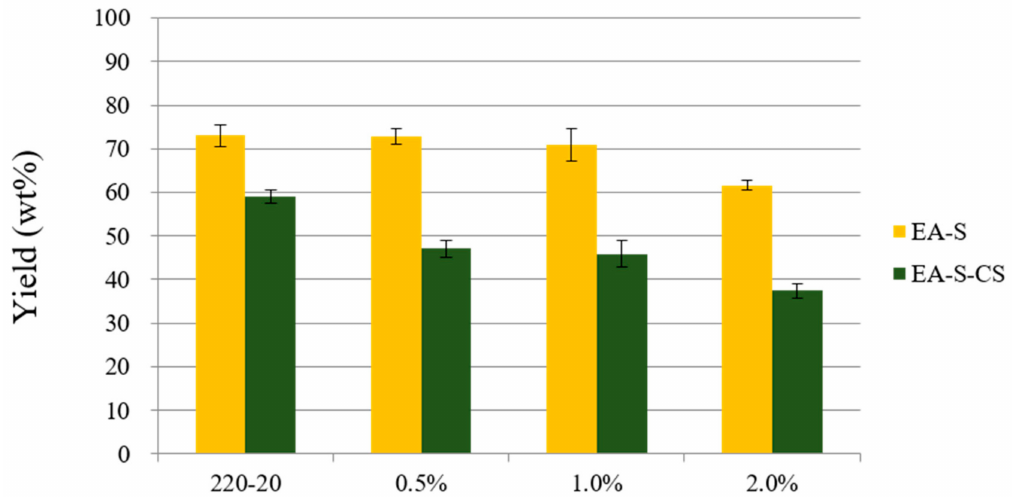
Figure 3. Yields of the solid fractions from acid catalyzed steam explosion (ACSE) and alkali-catalyzed organosolv treatment (ACO) of EFB.